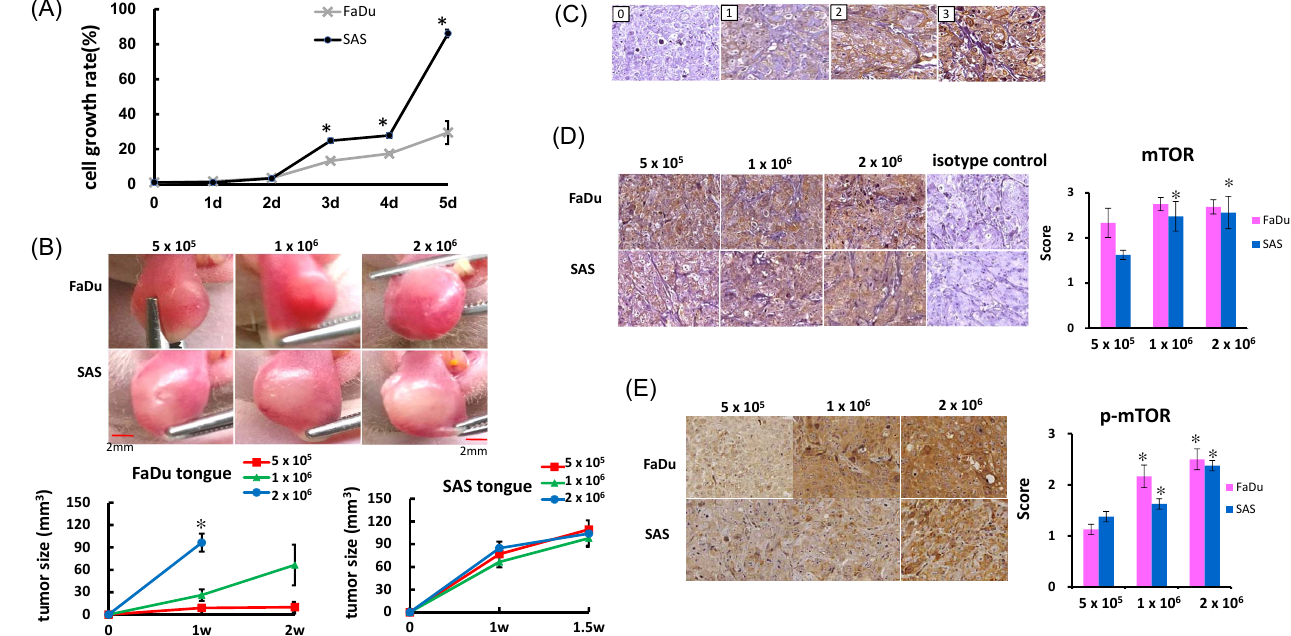
Figure 1. Basal characteristics of FaDu and SAS cells. ( A ) Cell growth was measured by trypan blue staining. Cells (1 × 10 4 cells in 3 cm culture dishes) were seeded and harvested at different time intervals. After mixing equal volumes of cells and trypan blue, cells were counted by using a hemocytometer. The highest variation in cell growth occurred after 5 days after initiation. Data are expressed as mean ± SD of three separate experiments with triplicate samples. * p -value < 0.05 calculated by a paired Student’s t-test. ( B ) NU/NU mice (6 mice per group) received submucosal tongue injections (5 × 10 5 –2 × 10 6 cells /30 µ L) of SAS and FaDu cells. The tongue tumors developed 7 days after injection. Tumor size was measured regularly using a digital vernier caliper. ( C ) Expression of the mTOR protein in HNSCC tissues. HNSCC tissues were immunohistochemically stained with an anti-mTOR antibody ( × 200). 0, no staining; 1, weak staining; 2, intermediate staining; 3, strong staining. ( D ) FaDu and SAS tumor growth was analyzed by mTOR and ( E ) p -mTOR immunohistochemistry staining from xenograft tumor tissues ( n = 6/group) ( × 200). Mouse mAb IgG1 isotype control, followed by goat anti-mouse IgG1. * p -value < 0.05. Error bars: Standard error of the mean